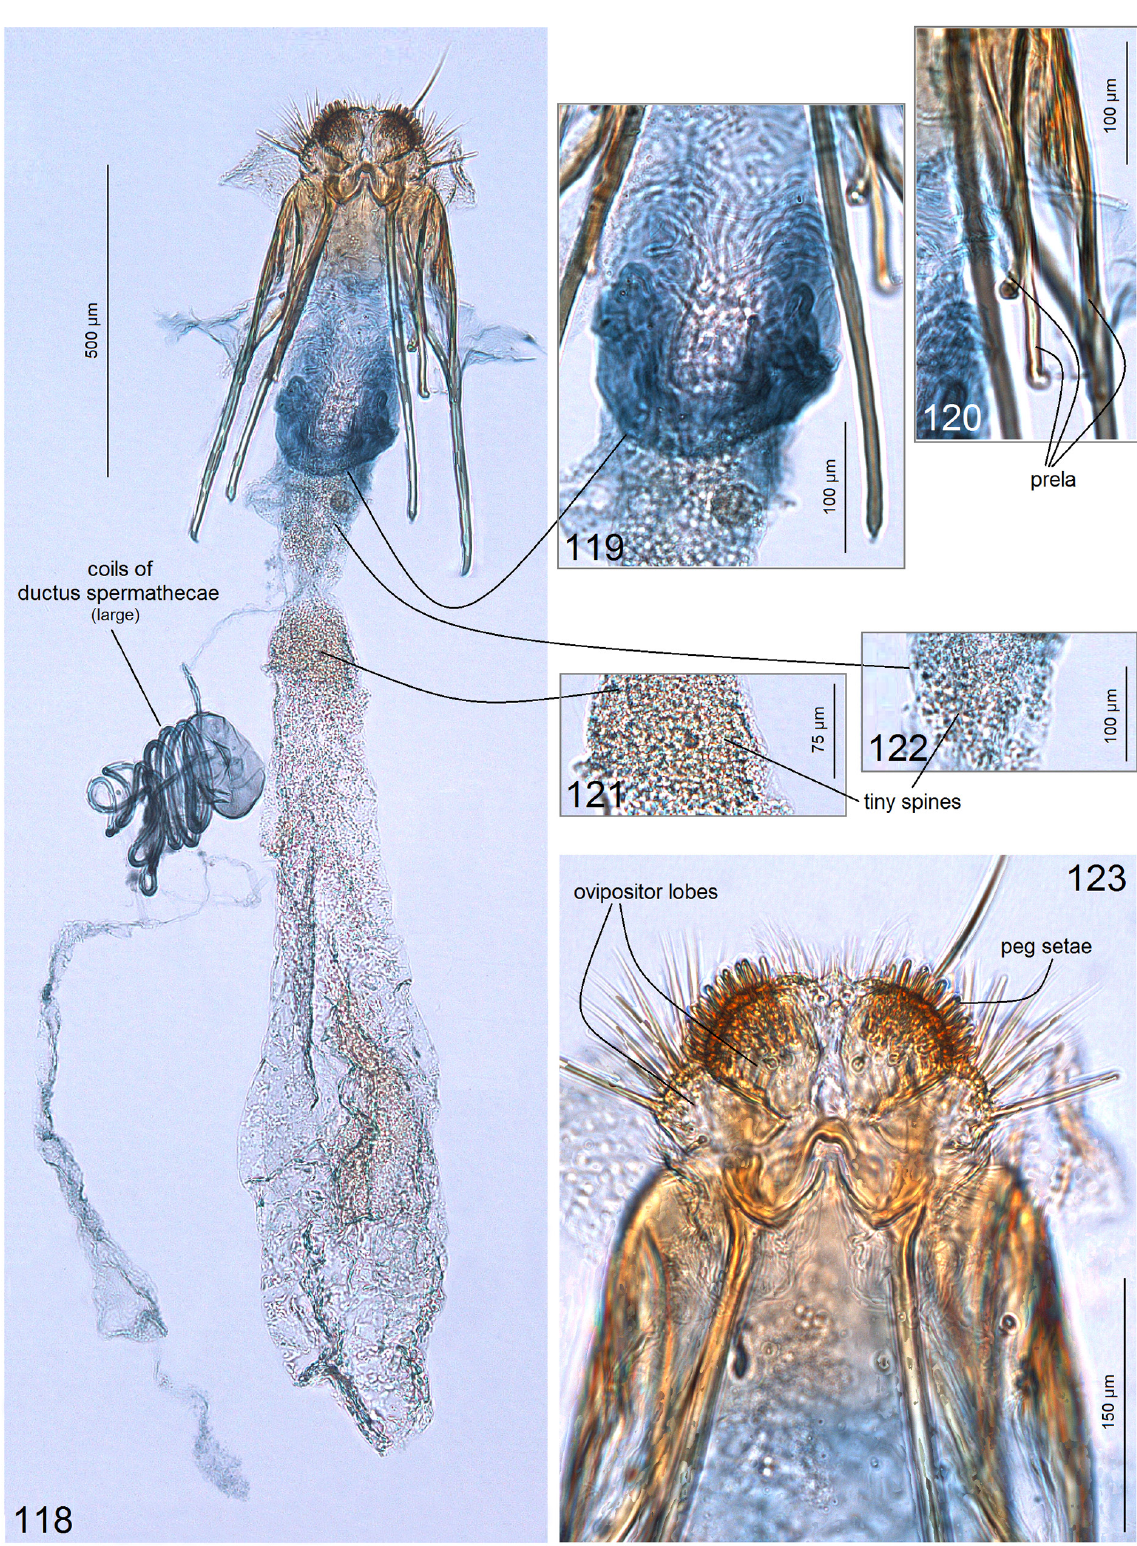
Figs 118–123. Female genitalia of Paratischeria tubifex Diškus & Stonis sp. nov., paratype (genitalia slide no. 010316173, NHMUK). 118 . General view. 119–122 . Details. 123 . Ovipositor